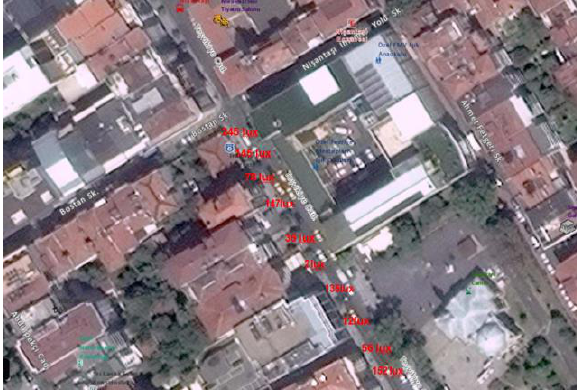
Figure 13. Measurement